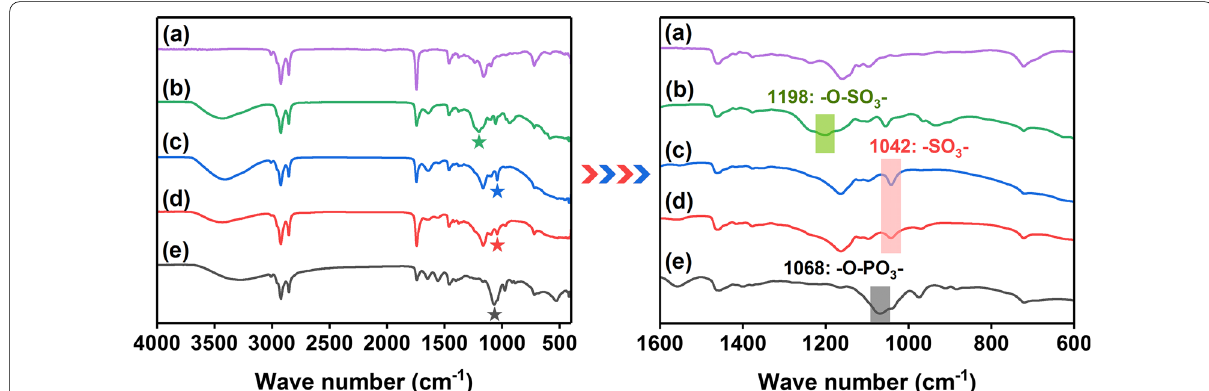
Fig. 5 ATR-FTIR spectra of rape oil ( a ), sulfated rape oil ( b ), sulfonated rape oil ( c ), oxidized–sulfited rape oil ( d ), and phosphated rape oil ( e )